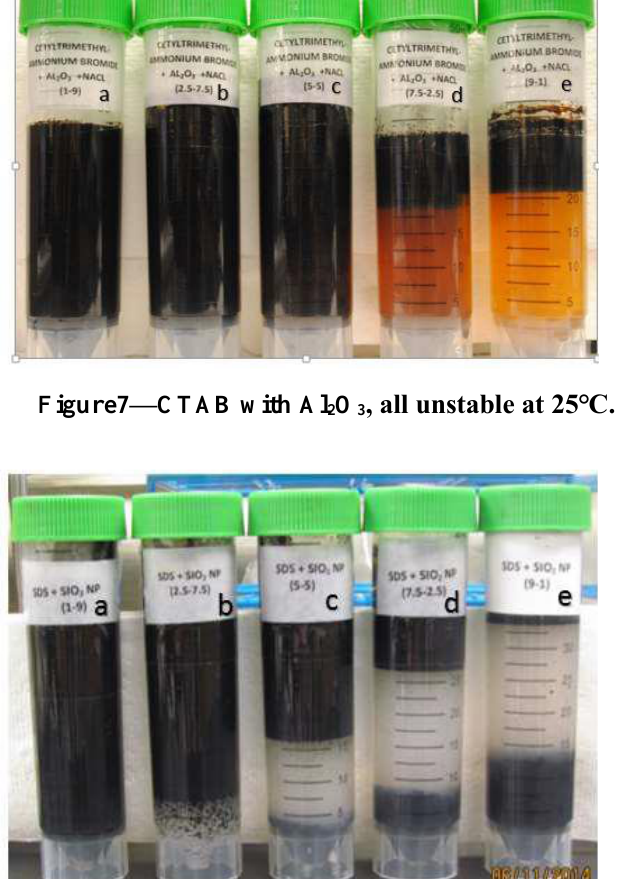
O where all systems are unstable at 25℃. 2 3